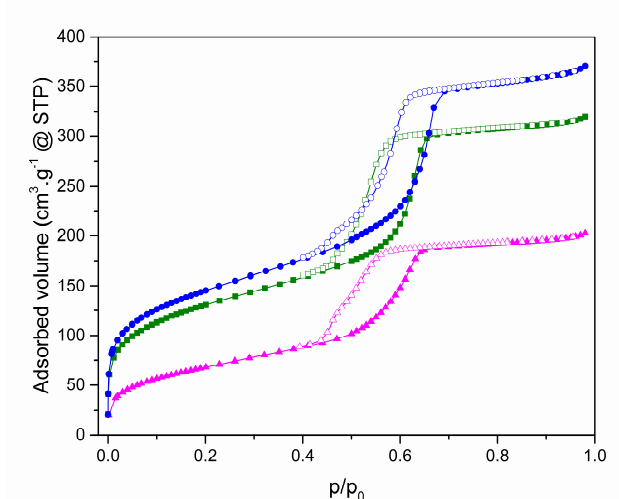
Figure 2. Isotherms of mesoporous silica SBA-15 before (blue) and after modification with 3-aminopropyl (cyan) and cyclohexyl (green)